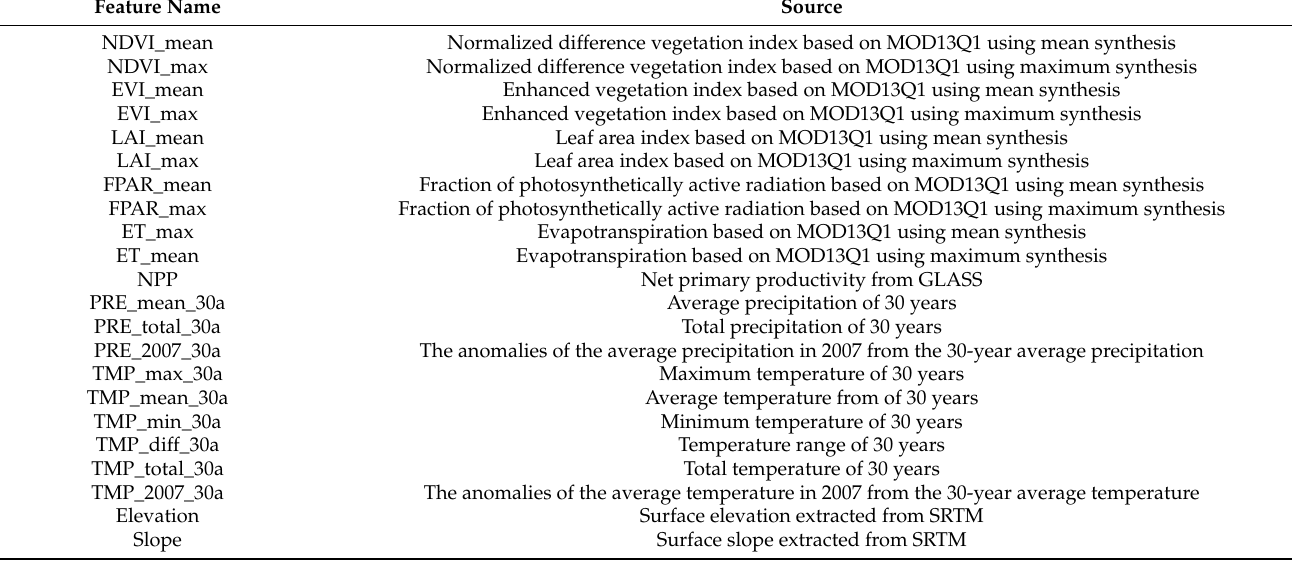
Table 3. Abbreviations and source of the 22